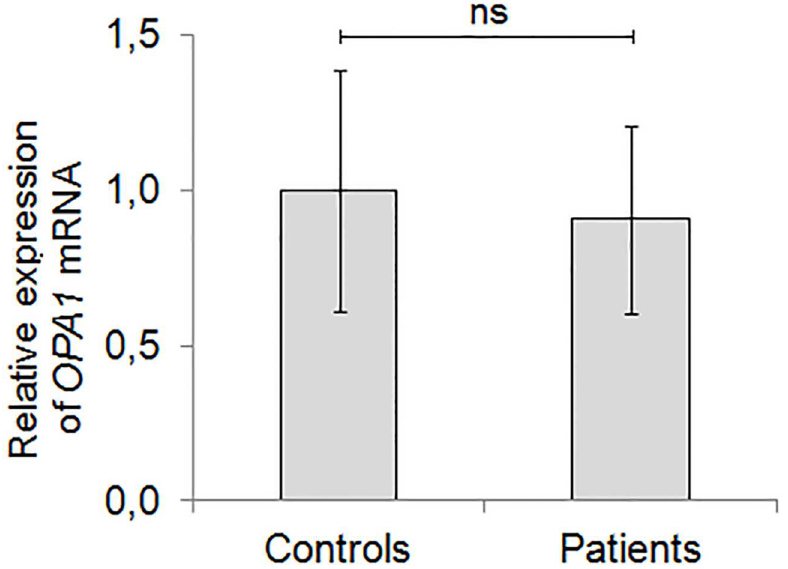
Fig 3. OPA1 expression at mRNA level. OPA1 mRNA level were quantified in PBMC in patients with p.Q31 * mutation and control samples from healthyindividuals. The amount of OPA1 mRNA was quantified by real-time PCR in relationto GAPDH . The values of control samples were set at 1.